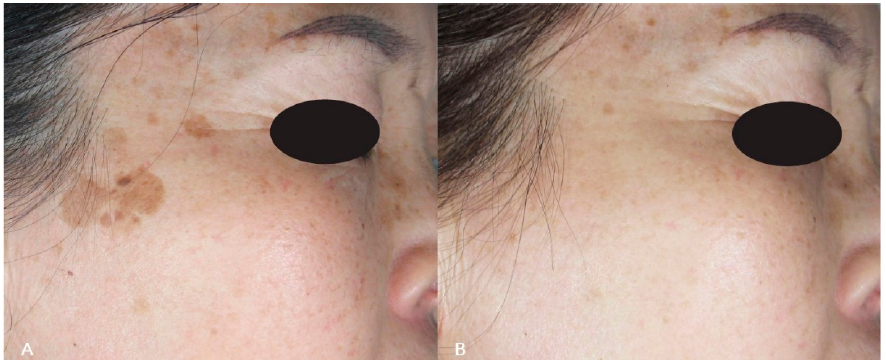
Figure 3. Patient 16 ′ s right side before ( A ) and after treatments ( B ).